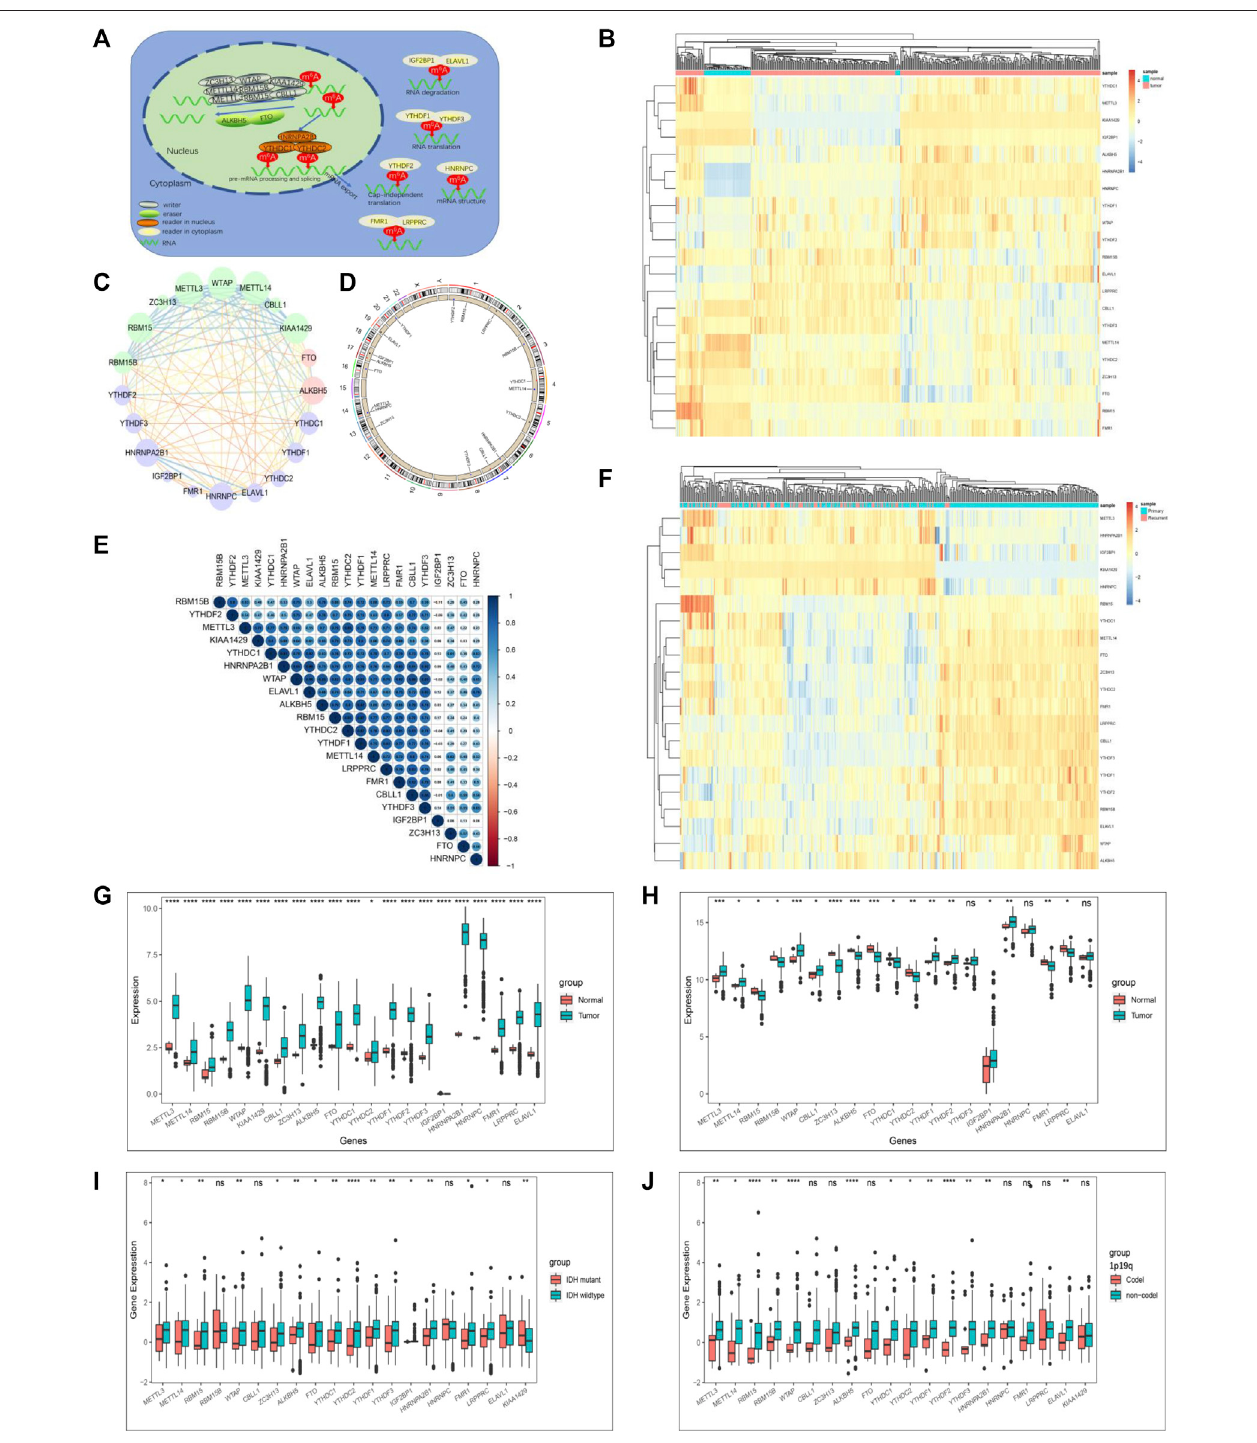
FIGURE 1 | The landscape of genetic variation of m6A regulators in GBM. (A) Reversible and dynamic processes of m6A RNA methylation mediated by 21 regulators and their potential biological functions for RNA. (B) Heatmaps of expression levels of 21 m6A RNA methylation regulators. Pink represents GBM samples, green represents normal samples. (C) A summary of protein-protein interactions between 21 m6A regulators. The lines linking regulators showed their interactions, the circlesizerepresentedtheconnectionstrengthofeachnode.Eraserswerelabeledaspinkdotsinthecircle;writerswerelabeledasgreendotsinthecircle;readers werelabeled asblue dots in the circle. (D) The location ofCNV alteration of21 m6A regulators on 23chromosomes. The red dot in the outer ring indicates ampli fi cation, while the blue dot in the inner ring indicates deletion. (E) Heatmaps of expression levels of 21 m6A RNA methylation regulators from 423 samples. Pink represents